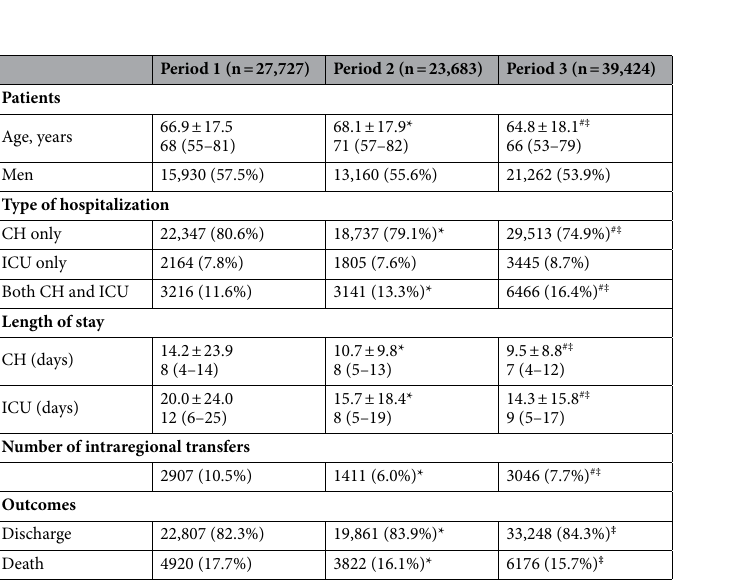
Table 1. Typology of patients and main characteristics of care pathway and outcomes for each period. Data are expressed in mean ± sd and P50 (P25-P75). CH conventional hospitalization, ICU intensive care unit, LOS length of stay. *Significant difference between period 1 and period 2. # Significant difference between period 2 and period 3. ‡ Significant difference between period 1 and period